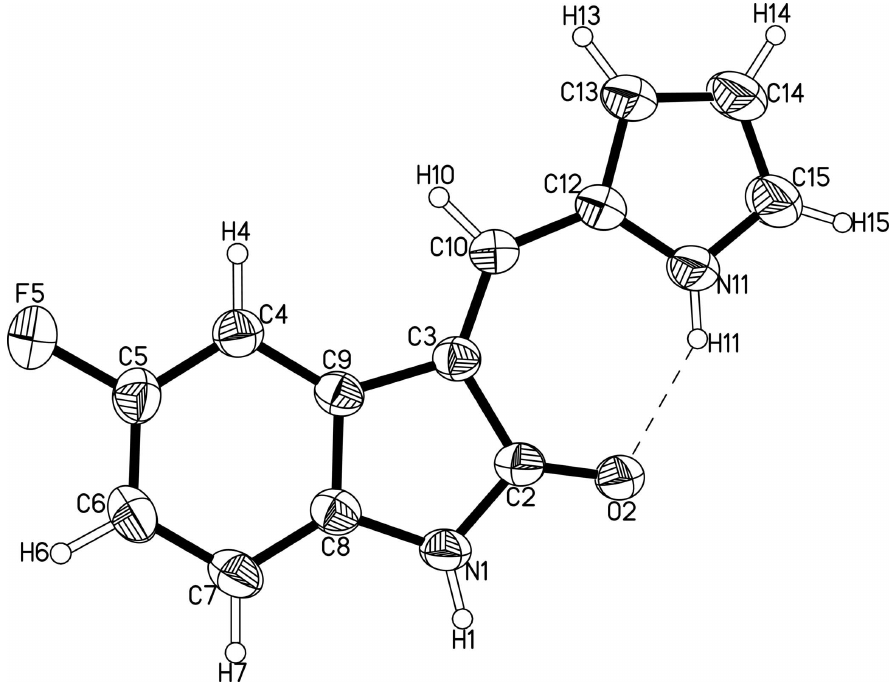
Figure 1 A view of one of the independent molecules with displacement ellipsoids drawn at the 40% probability level. Dash lines indicate the intramolecular hydrogen bond. H atoms are presented as open circles with arbitrary radii.